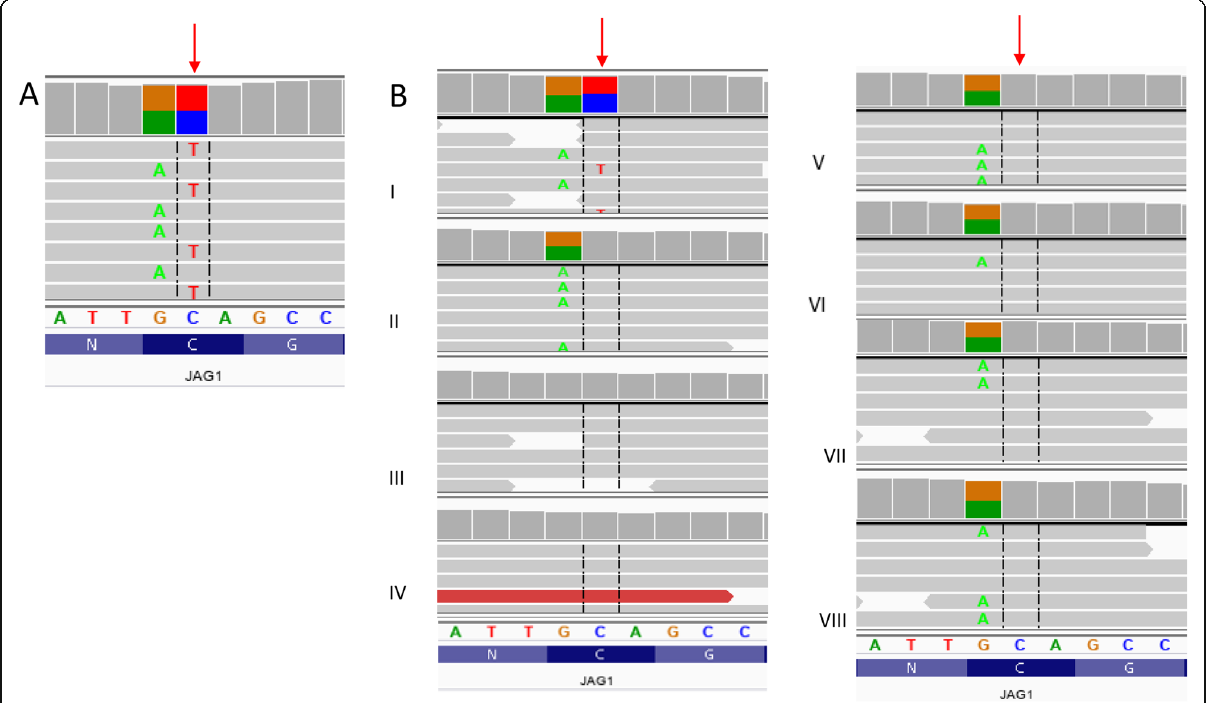
Fig. 2 a Results of WES in the proband, b results of deep amplicon sequencing in the proband and her relatives (I – proband, II – mother, III – father, IV-VIII – siblings) Red arrow indicates c.587 position in the JAG1